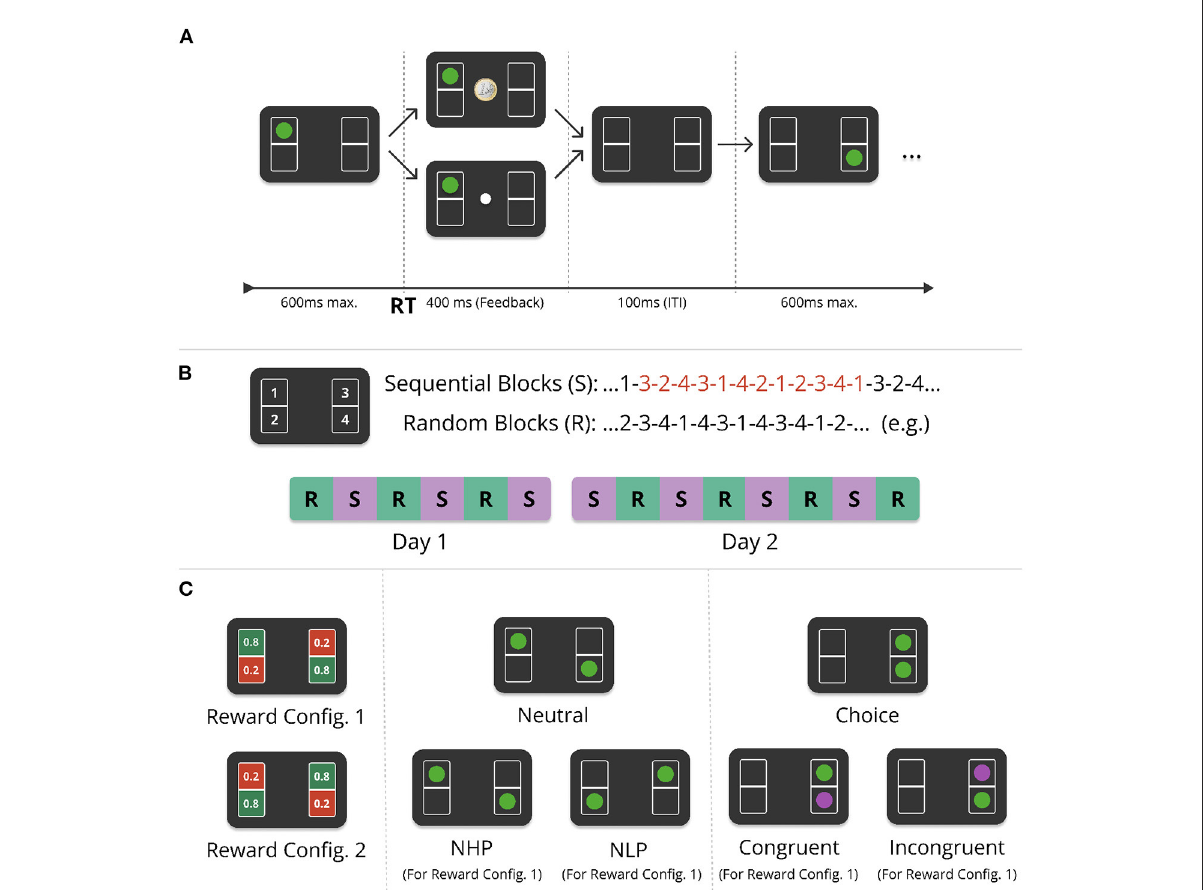
FIGURE1 Experimental design of the Action-Sequence Task (AST). (A) In each trial, participants saw one or two green target stimuli placed in four different boxes (here a single target is shown). Participants had to press one of four corresponding keys on the keyboard in response to the target position(s), within a deadline of 600 ms after stimulus onset. When pressing the correct key, a reward was paid out probabilistically. If the trial was rewarded, a euro coin was shown in the center of the screen. In the case of no reward, a white dot appeared instead. The feedback (FB) lasted for 400 ms (or 250 ms, depending on the experimental group and phase of the experiment, see Supplementary Figure S1). After the feedback phase, there was an inter-trial-interval (ITI) of 100 ms. (B) There were two experimental conditions: In the sequential condition (S), targets kept repeating the same 12-item sequence (red digits), while in the random condition (R), targets appeared pseudo-randomly red numbers (see main text for details). The experiment was performed over the course of two consecutive days with alternating sequential and random blocks, six blocks on day one and eight blocks on day two, each block consisting of 480 trials. (C) (Left) The reward probabilities were associated with specific positions on the screen and were either 0.8 or 0.2. Reward probabilities did not change over the entire experiment and were counterbalanced with one half of participants being presented with reward configuration 1 (RC1), and the other half with RC2. Dual-target trials (two green targets) appeared pseudo-randomly, with a frequency of between 68 (14.2%) and 78 (16.3%) per block. In the sequential condition, one of the two targets always corresponded to the current sequence element. Both targets can have the same reward probability [ neutral (dual-target) trials], Center, or different reward-probabilities [ choice (dual-target) trials, Right]. Neutral trials are further differentiated into trials where both targets have a low reward-probability [neutral low-probability (NLP) trials], or a high probability [neutral high reward probability (NHP)]. Choice trials , when appearing in the sequential condition, are further differentiated into two different trial types. If the sequence